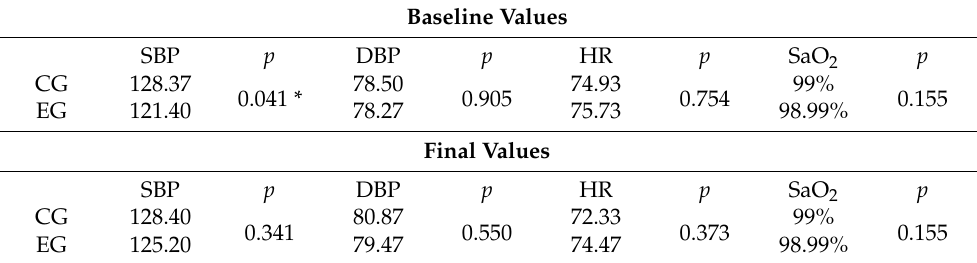
Table 1. Differences in mean and statistical significance ( p < 0.05) in both groups between baseline and final